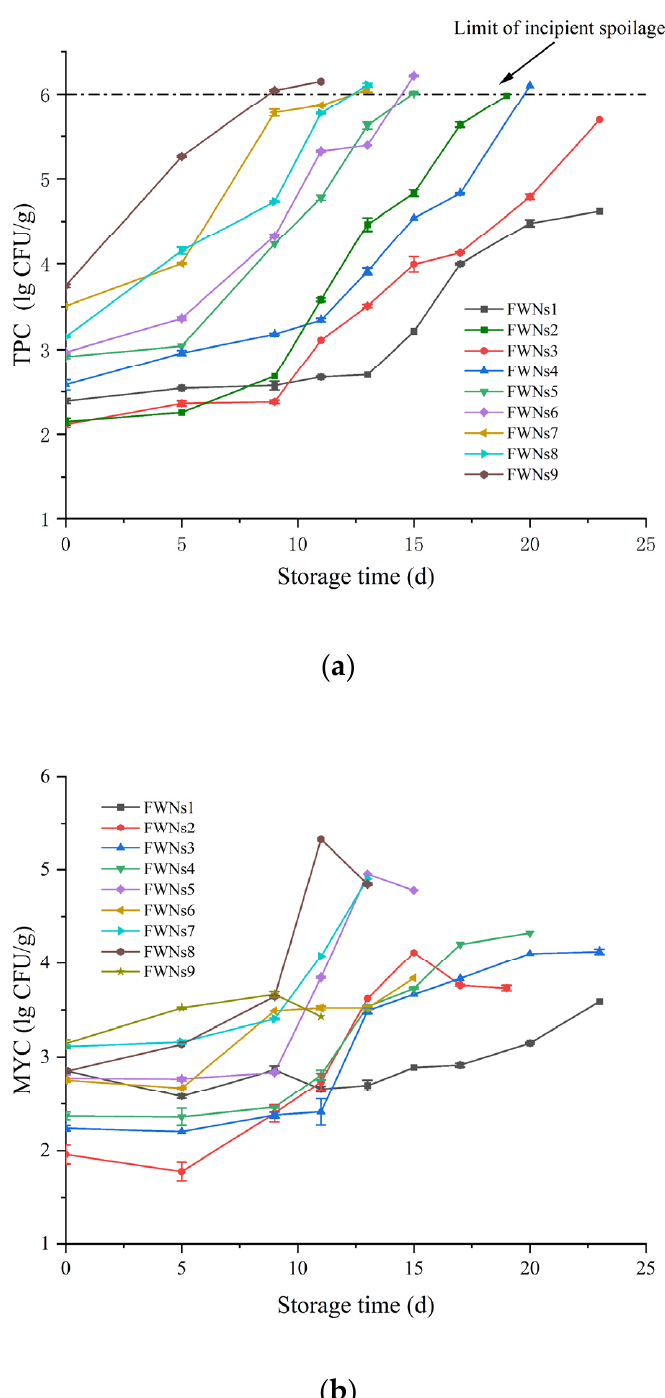
Figure 1. Changes of microbial concentration in FWNs prepared from flour with different bacterial concentration during storage at 4 °C. FWNs1 − FWNs9 samples were prepared from F1 − F9 respec- tively. ( a ) TPC changes in FWNs1 − FWNs9 samples during storage at 4 °C; ( b ) MYC changes in FWNs1 − FWNs9 samples during storage at 4 °C.